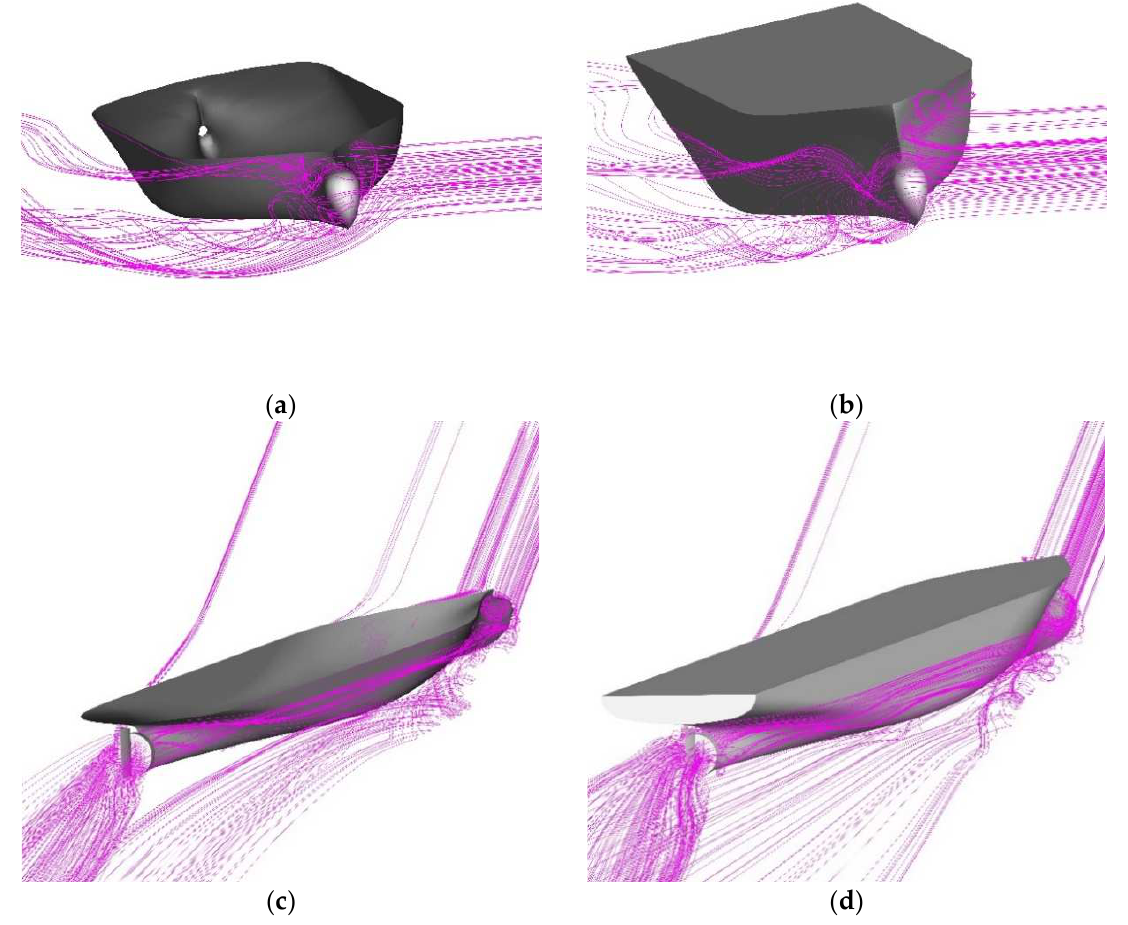
Figure 7. Streamlines around the hull for simulations of double-body flow (left) and water–air flow (right) at Fr = 0.201 and β = 16 deg. ( a , b ): streamlines around the bow. ( c , d ): streamlines around the hull.